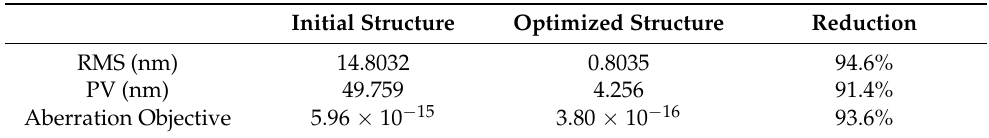
Table 1. Performance comparison between the optimized and initial structure of the primary mirror in the vertical optical axis.